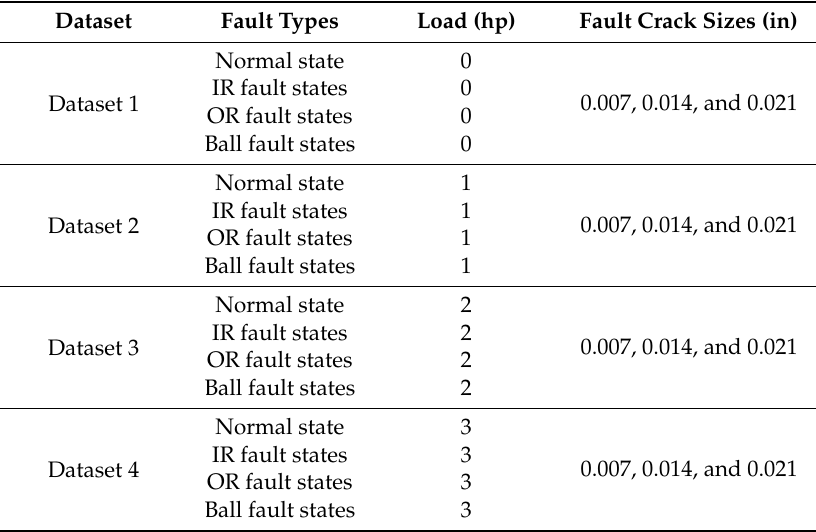
Figure 7. The seeded roller bearing test rig for recording fault data. Table 2. The detailed description of the datasets used in this